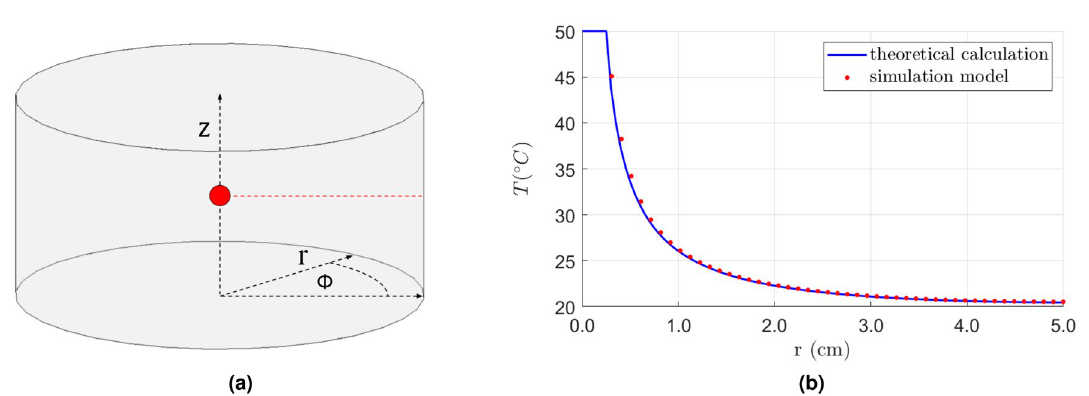
Figure 3. Validation of the model: illustration of the setup in the cylindrical coordinate system ( a ) and temperature distribution on the cylinder radius originating in the heat source center (red profile in ( b ), z = h = 2.5 cm) ( b